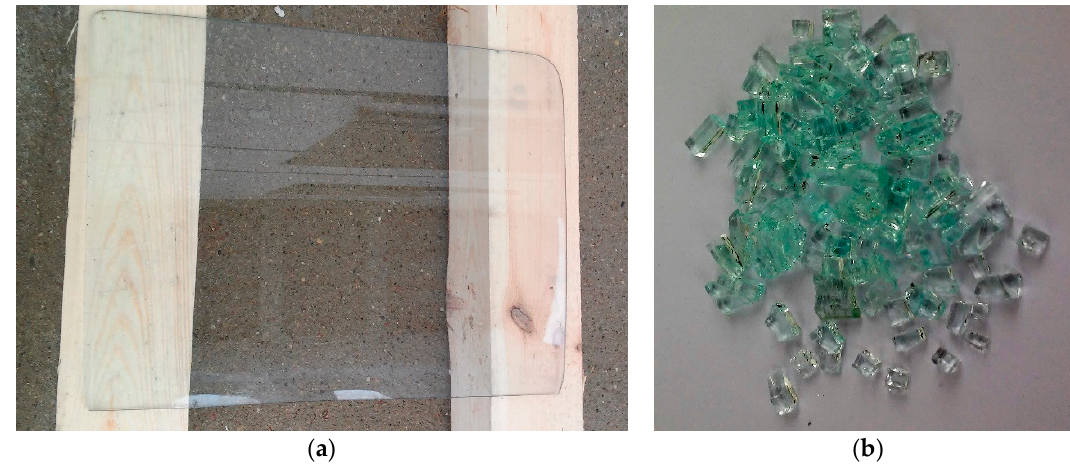
Figure 1. Waste glass raw material: ( a ) in the form of a solid window; ( b ) after crushing.